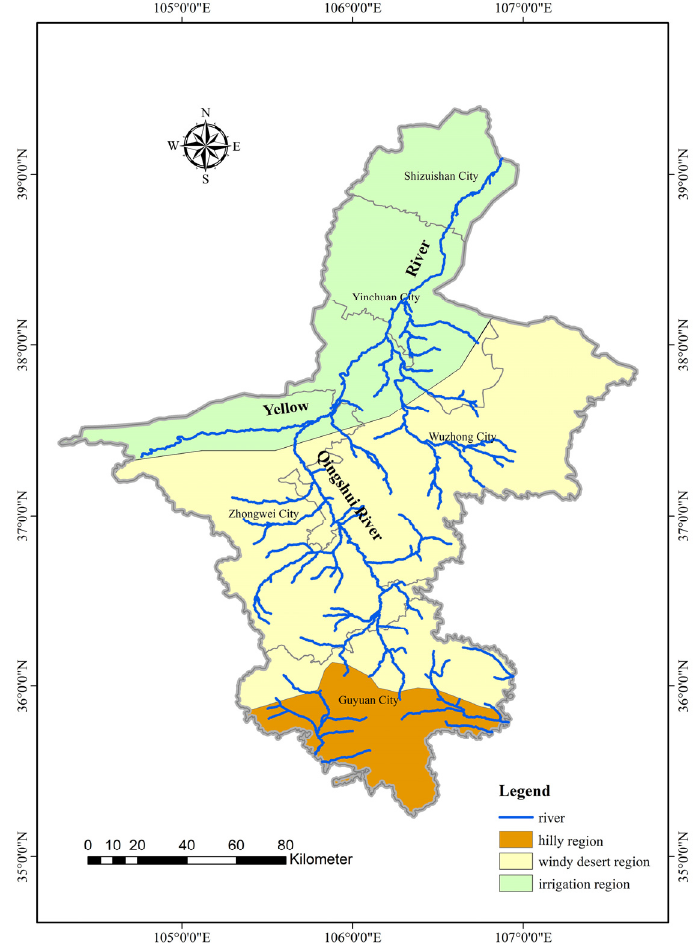
Figure 1. Main partitions of Ningxia topography and landforms.